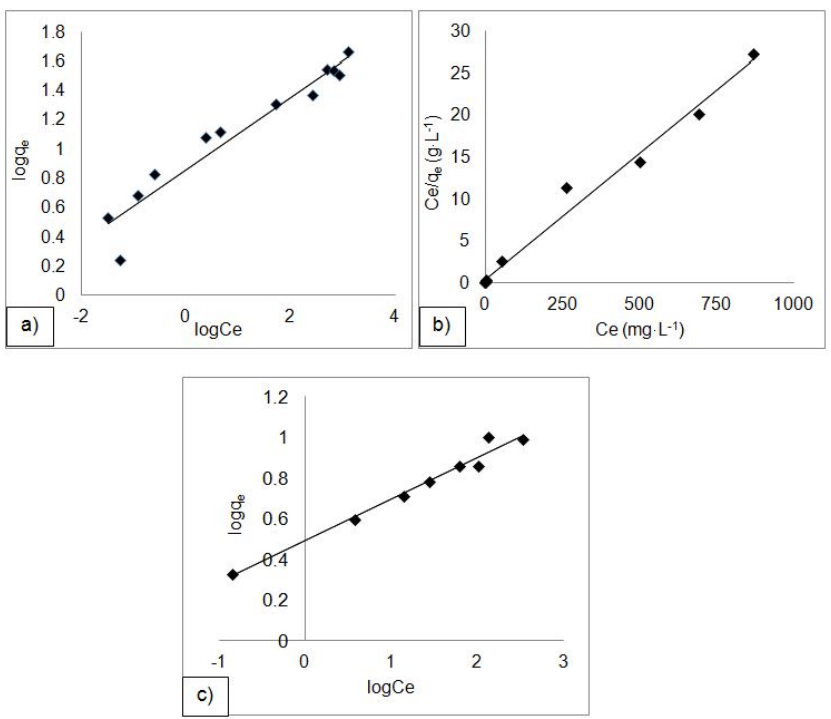
Figure 6. Isotherm models: ( a ) Freundlich model plot for Pb adsorption, ( b ) Langmuir model plot for Pb adsorption, and ( c ) Freundlich model plot for Cu adsorption.